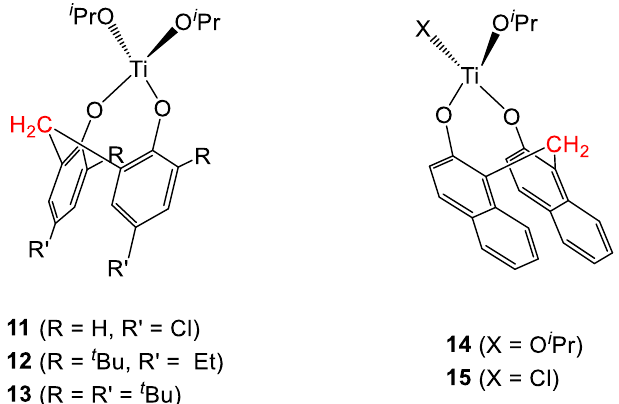
Table 3. Ethylene polymerization catalyzed by 1 , 4 , 6 -10 /MAO systems [8].